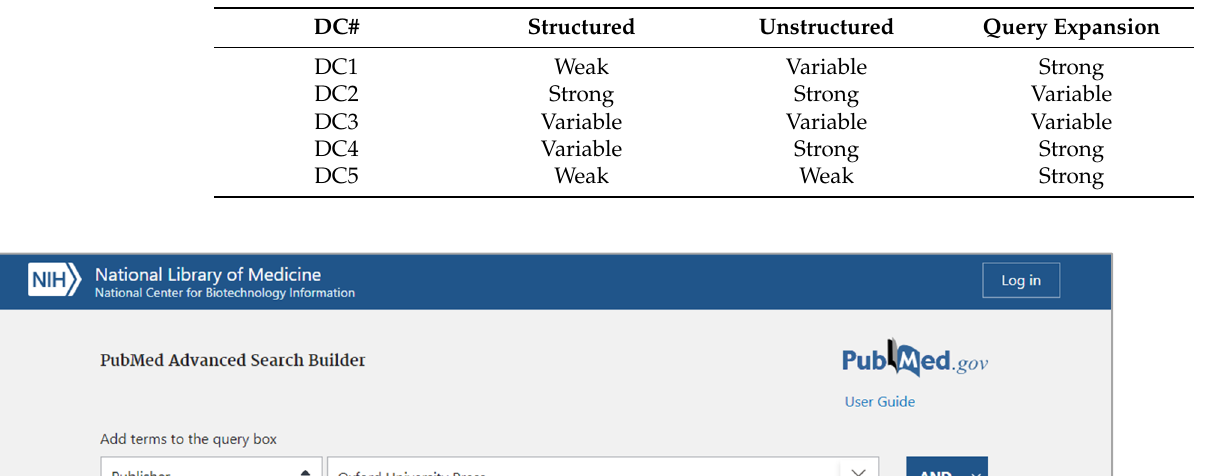
Table 2. A summary matrix of alignment between the criteria and interface strategies. Full descrip- tions are found within their respective sections. “Strong” is assigned if a characteristic of the interface strategy promotes alignment with the requirements of the design criterion. “Weak” is assigned if a characteristic of the strategy does not promote alignment with the requirements of the design criterion. “Variable” is assigned if the interface strategy has the potential to align with the criterion; however, such an alignment is not innate and must be actively pursued.